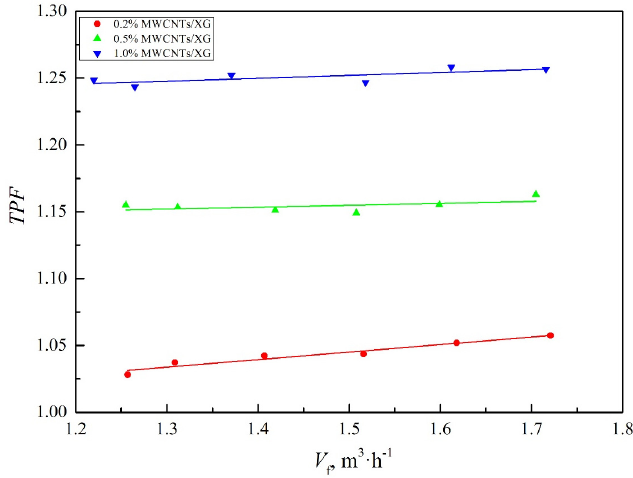
Figure 13. Comprehensive thermal performance factor versus volume flow